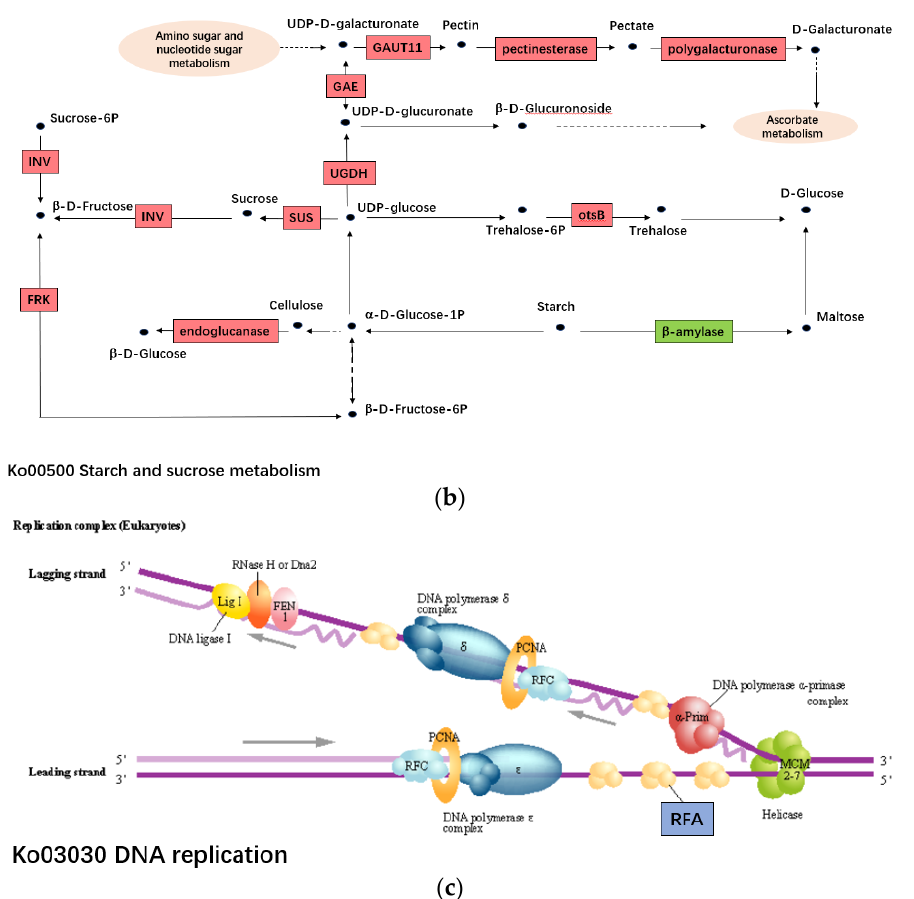
Figure 6. The pathways of DEGs’ participation. ( a ). The pathway of plant hormone signal transduc- tion (ko04075). ( b ). The pathway of starch and sucrose metabolism (ko00500). ( c ). The pathway of DNA replication (ko03030).